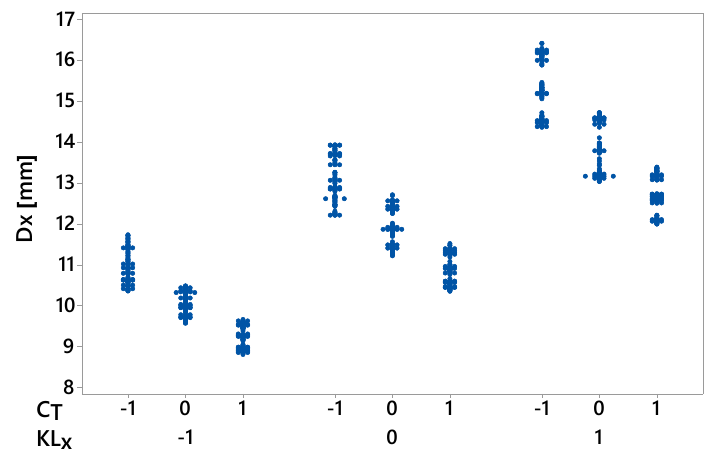
Figure 13. Maximum displacement in the x -direction with counter